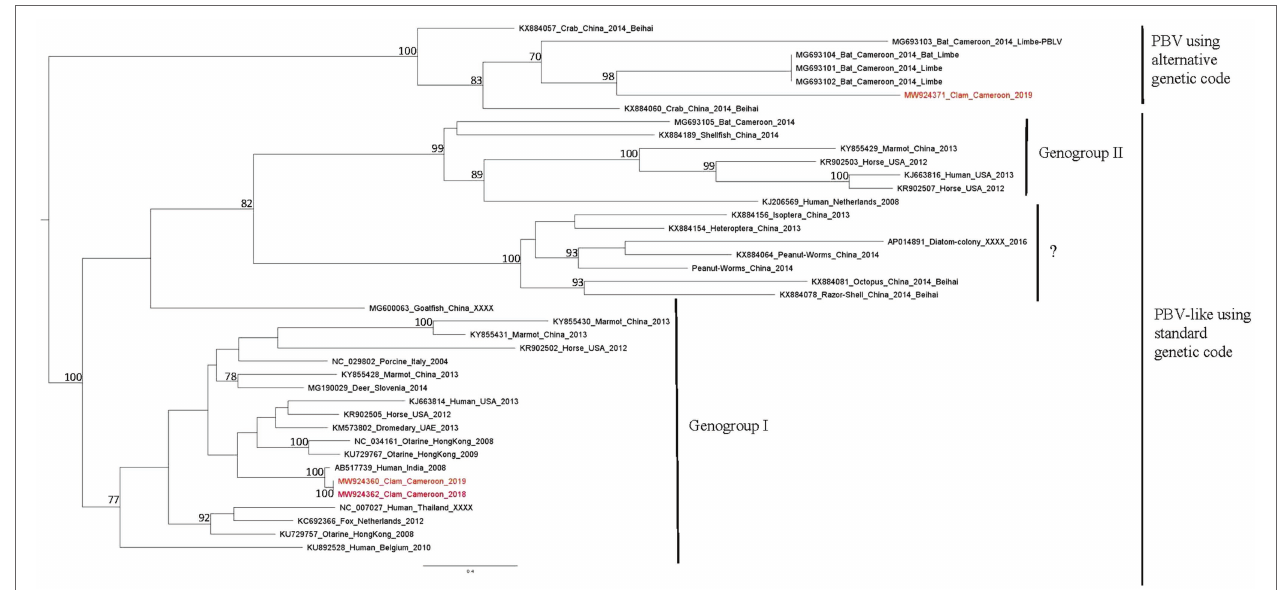
FIGURE 6 | Phylogenetic tree of RdRp sequences of picorbirnavirus. Reference sequences were selected to represent the three main clusters of picobirnavirus, sequences identified in this study are written in red. The tree was constructed using the Best-fit rtREV+F + G4 chosen according to BIC, boostrap values greater than 70% are